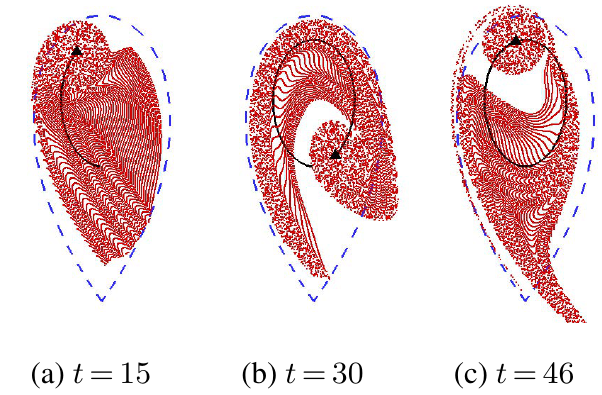
Fig. 7. The same as in Fig. 6 due to corotation of the monopole and Fig. 6: An example of particle scattering in the upper-layer topographic vortex, κ = 0 . 1 , y 0 = − 3 . Fig. 7: The same as in fig. 6 due to co-rotation of the monopole case due to counter-rotation of the monopole and monopole and topographic vortex, κ = 0 . 1 , y = − 3 . 5 . Bold black curve topographic vortex, κ = − 0 . 1 , y 0 is the trajectory of the monopole, with a triangle that shows the monopole current position.